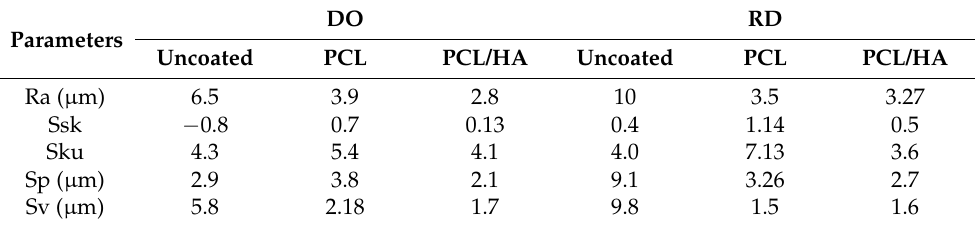
Figure 9. Roughness maps of DO and RD ( A , B ) uncoated, ( C , D ) coated with PCL and ( E , F ) with PCL/HA. Table 8. Roughness parameters estimated from roughness maps. Table 8. Roughness parameters estimated from roughness